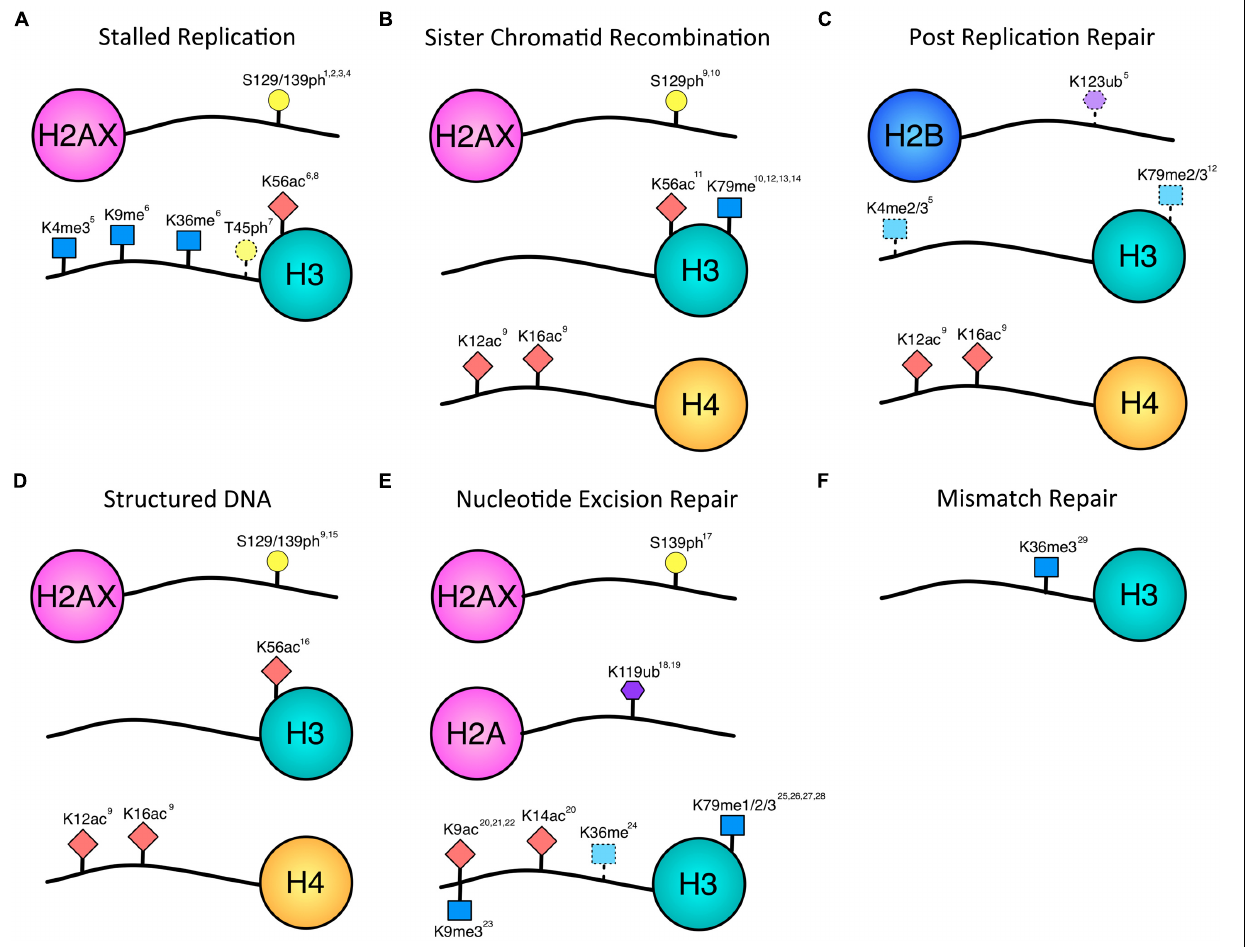
homology-mediate repair events. (D) Histone modifications associated with structured DNA.These modifications also impact the fidelity with which the DNA is repaired. (E) Histone modifications occurring during nucleotide excision repair. A decrease in H3-K9me is indicated by the downward facing blue square. H3-K36 methylation may be associated with transcription and/or TCR. (F) The only histone modification shown to be necessary so far